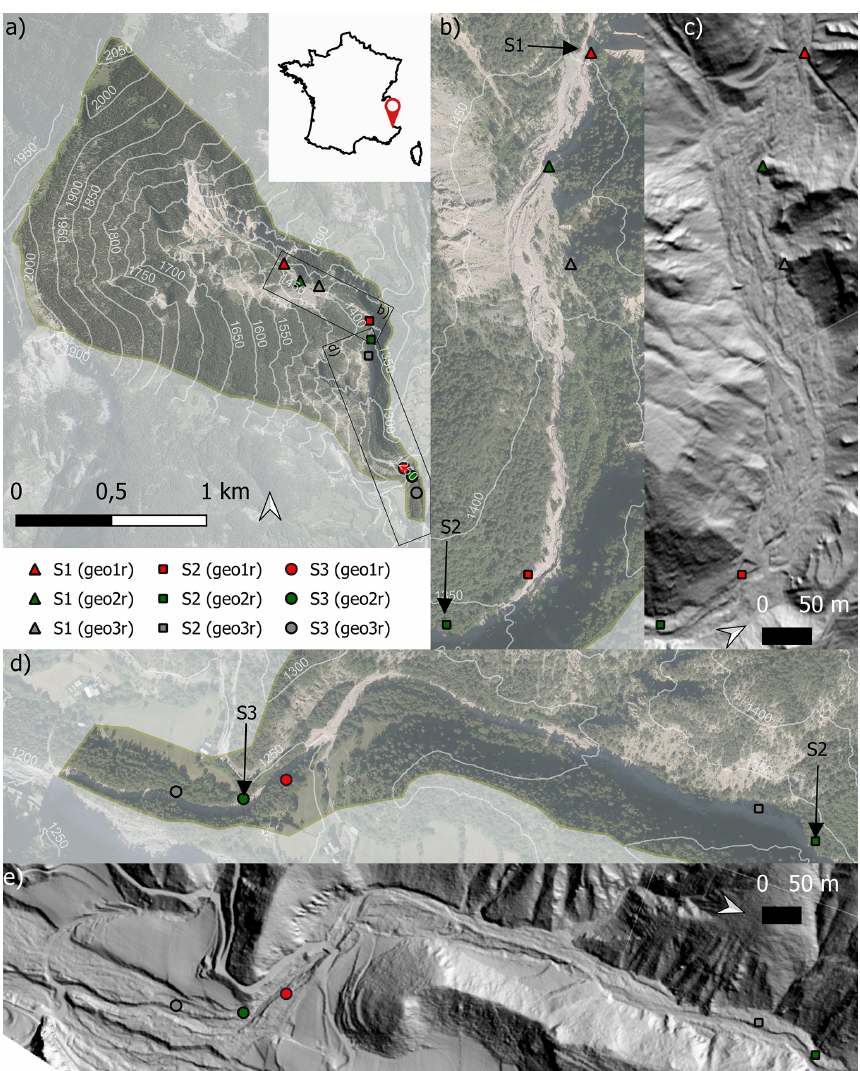
Figure 5. Overview of the installation on the Réal torrent. (a) Full location of the torrent and its stations. Drainage area is highlighted, as well as the three stations. Arrows show the position of the flow height sensor. The geo_XX labels denominate the geophones at each station ( r or l signifies right or left bank). (b) Aerial photography of station S 1 . (c) Digital elevation model (DEM) of station S 1 . (d) Aerial photography of stations S 2 and S 3 . (e) DEM of stations S 2 and S 3 (aerial pictures from BD ORTHO of the French geographical survey,